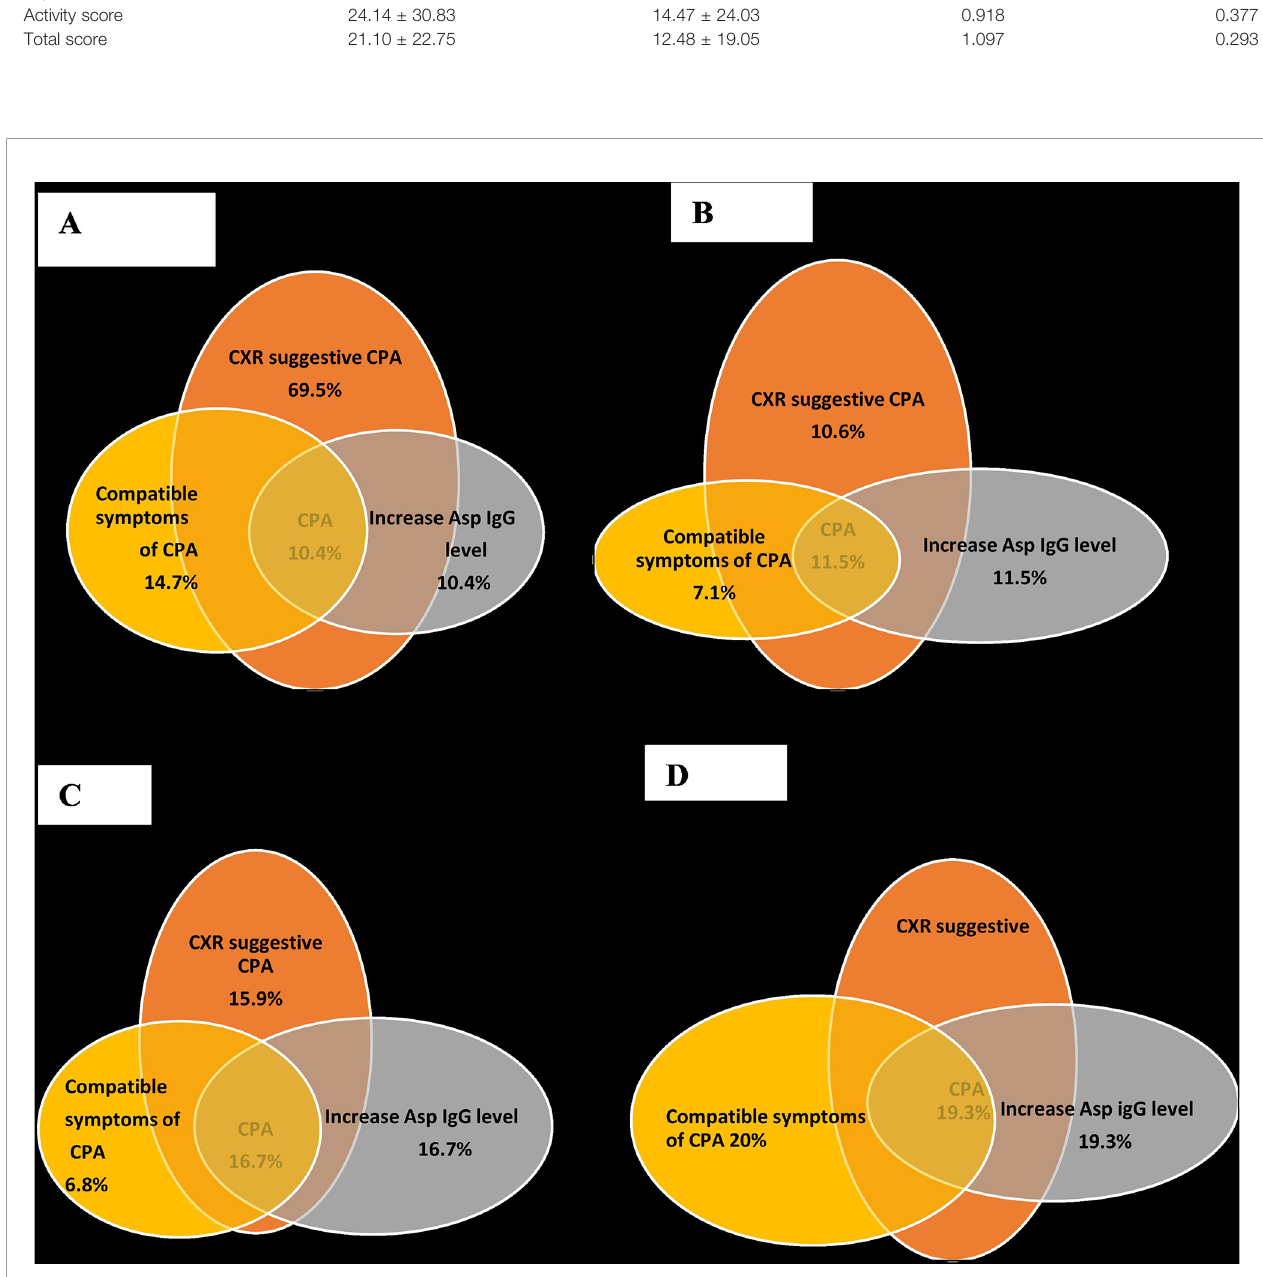
FIGURE 2 | Assessment of CXR fi ndings in studied population. (A) Baseline, (B) 6 months, (C) 9 months, (D) 12 months.